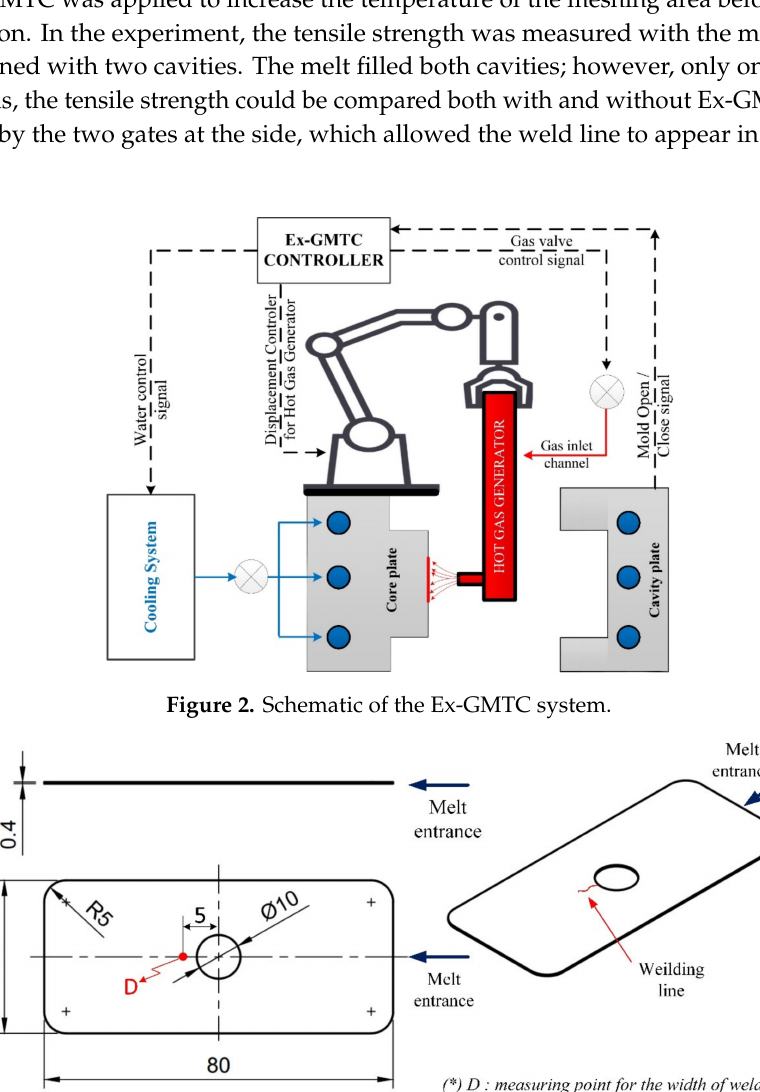
Figure 3. Dimensions of product used in the weld line appearance experiment.